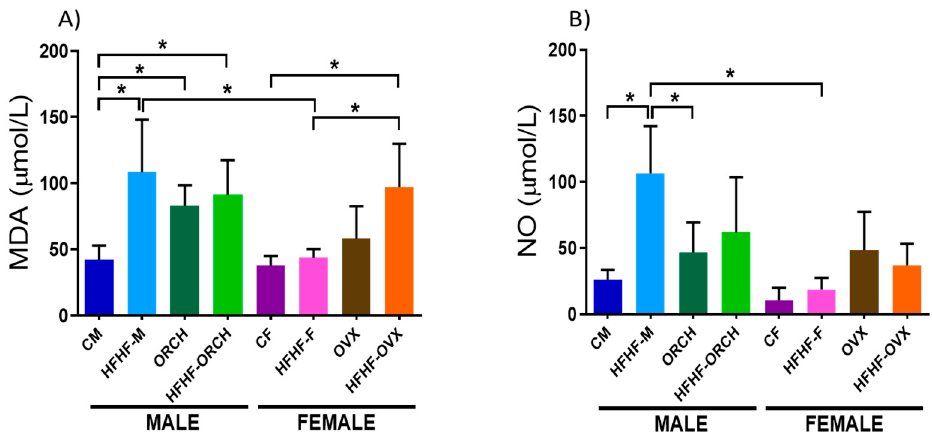
Figure 5. Effect of HFHF diet on oxidative stress markers. ( A ) Effects of HFHF diet on the concen- tration of MDA. ( B ) Effects of HFHF diet on the concentration of NO. CM: control males,